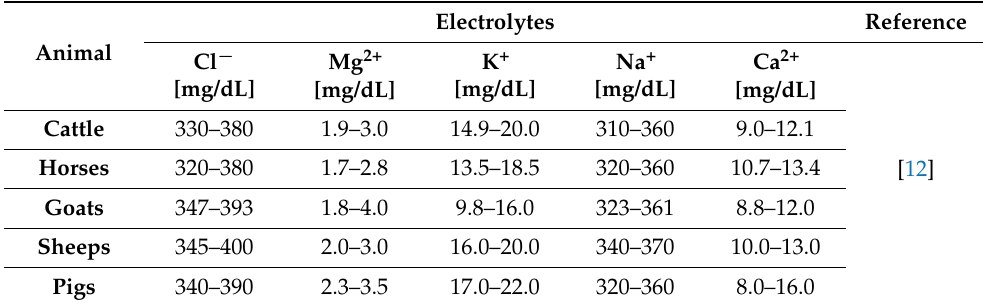
Table 2. The reference values of selected electrolytes in the blood serum of